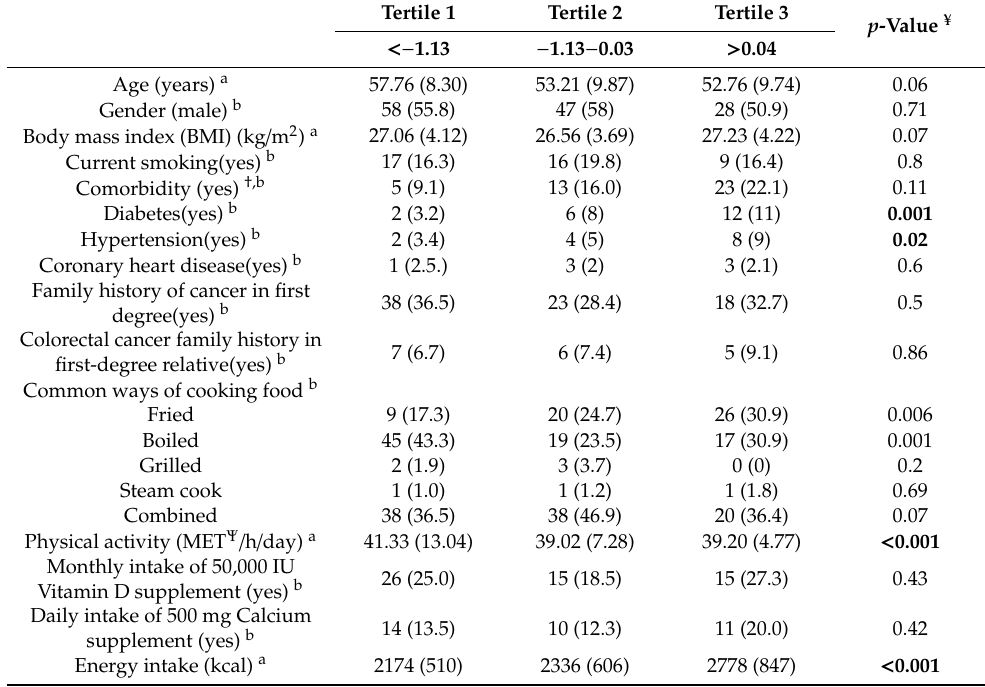
Table 2. Participant characteristics by tertile of the energy-adjusted dietary inflammatory index score (E-DII) among controls, Iranian CRC and CAP case-control study, Tehran, 2017–2018. Tertile 1 Tertile 2 Tertile 3